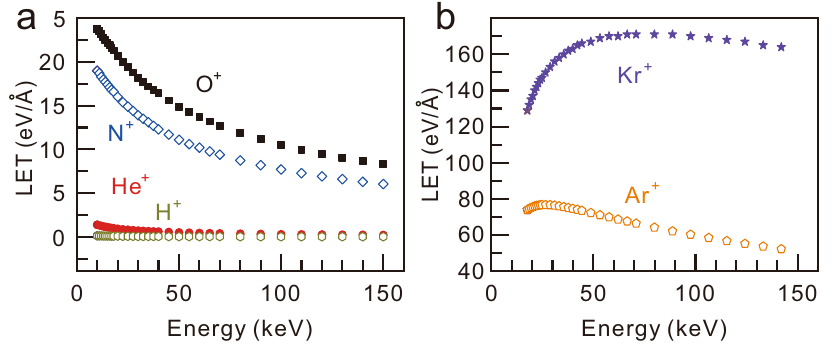
Figure 2. LET as a function of energy for various ion species: H + , He + , N + , and O + ( a ) and Ar + and Kr + ( b ).